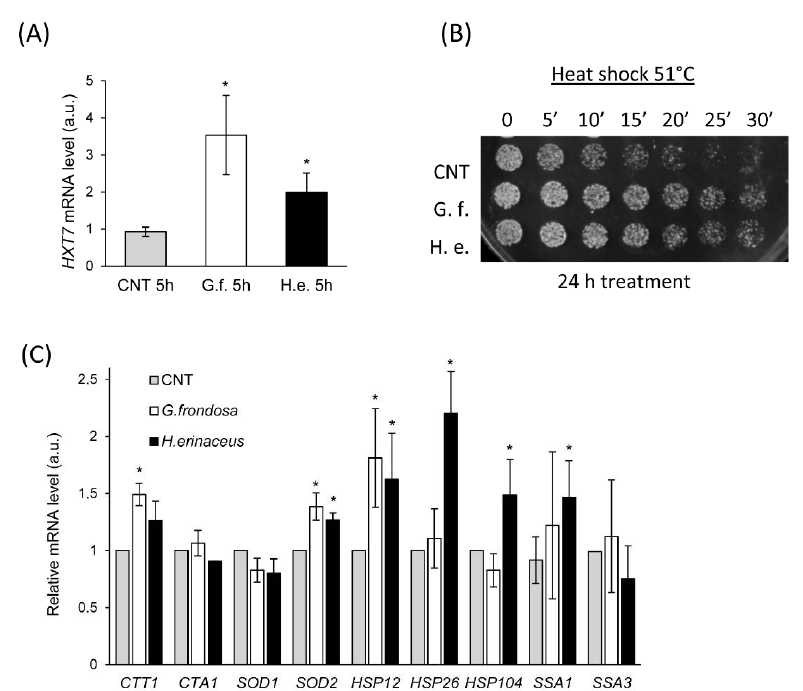
Figure 4. Fungal extracts inhibit the Ras/PKA pathway. ( A ) Real time PCR quantification of HXT7 mRNA in cells treated or not with 0.5% extract of G. frondosa or H. erinaceus for 5 h. ( B ) Drop test on YPD plates of wt cells (CNT) treated or not with 0.5% extract of G. frondosa or H. erinaceus for 24 h, after heat shock at 51 °C for the indicated time. ( C ) Real time PCR quantification of mRNAs of the indicated genes encoding for heat shock proteins in cells treated or not with 0.5% extract of G. fron- dosa or H. erinaceus for 24 h. * p < 0.05.